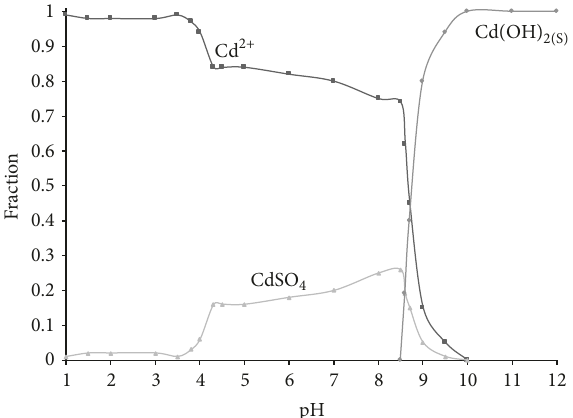
Figure 3: Specification diagram for Cd ( OH ) 2(